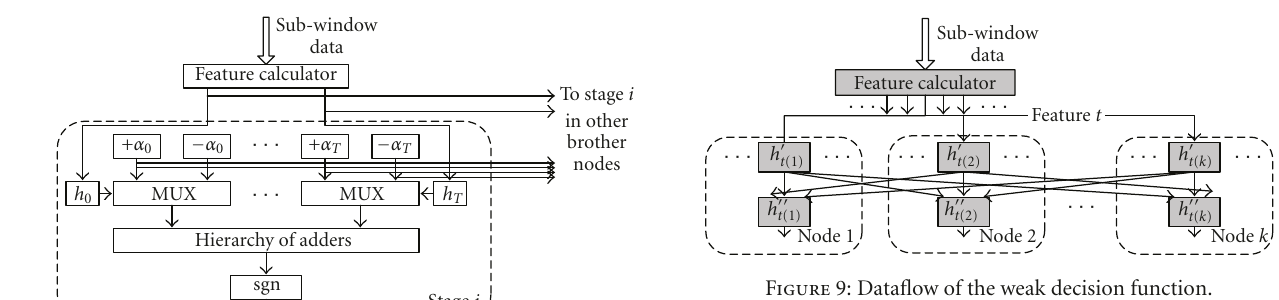
Figure 9: Dataflow of the weak decision function.